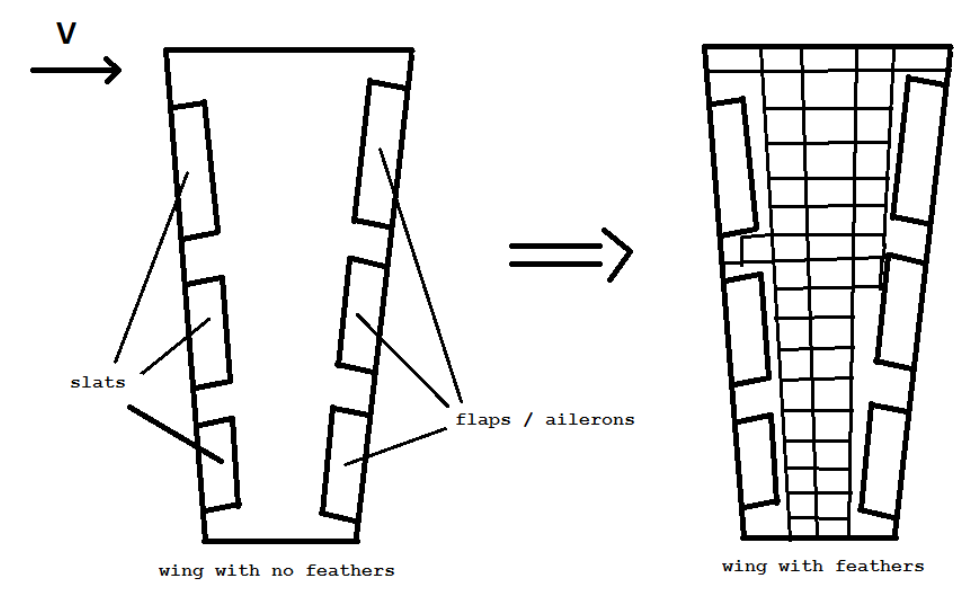
Figure 1. Wing with